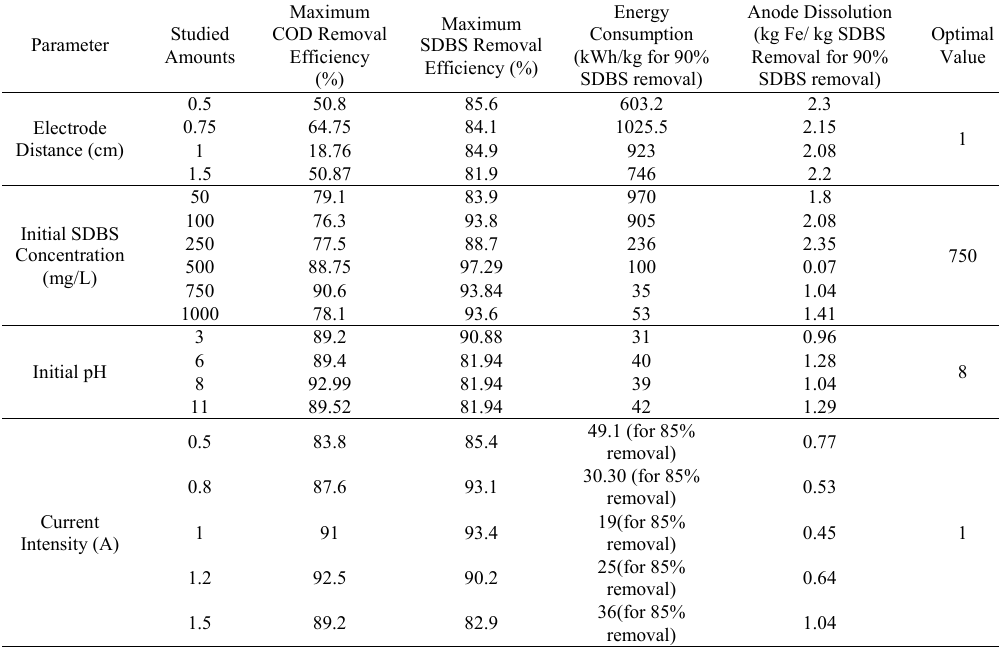
Table1. Results of Electro Flotation System Table 1. Results of Electro Flotation